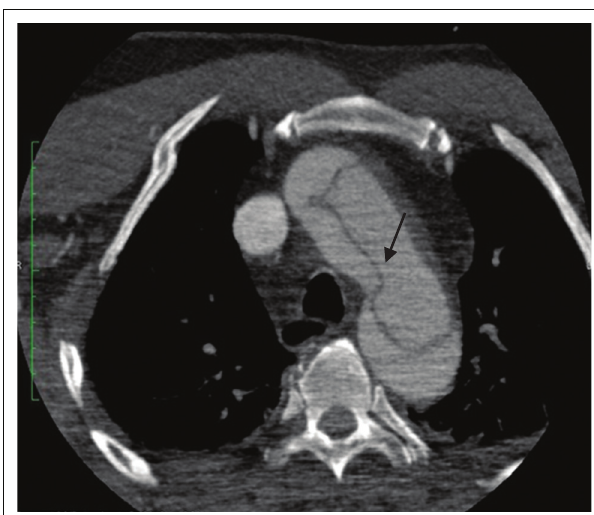
FIGURE 2: Contrast-enhanced axial computed tomography scan demonstrating a displaced intimal flap (arrow), separating the true and false lumens in a patient with a Stanford Type A aortic